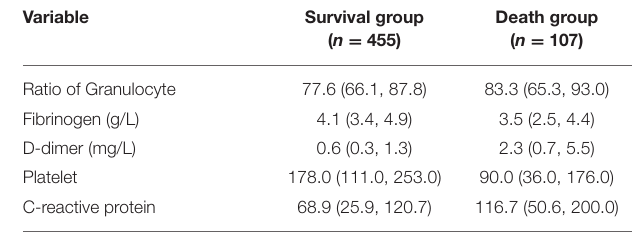
TABLE 1 | Basic characteristics of 562 patients with streptococcal bloodstream infection.